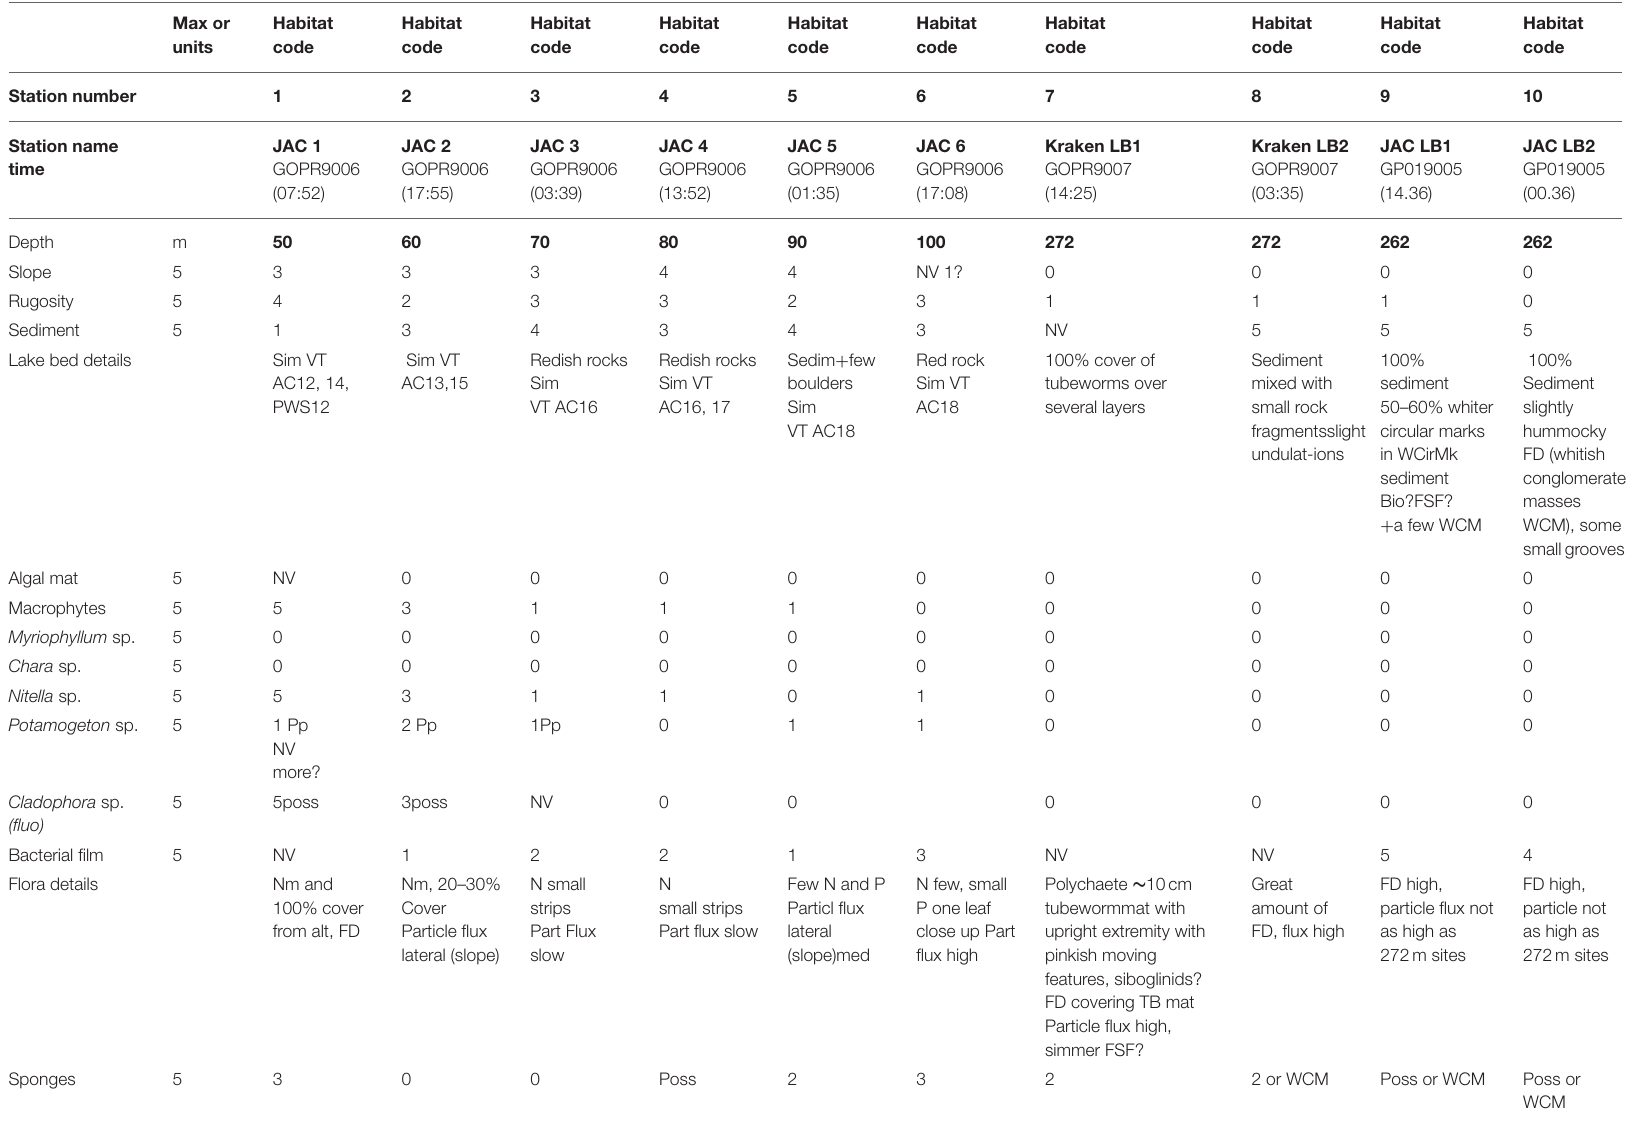
TABLE 2 | Results of analysis of the video sequences on drop-down dives using the deep-water lander, showing the geomorphological characteristics of the substrate and the most evident flora and